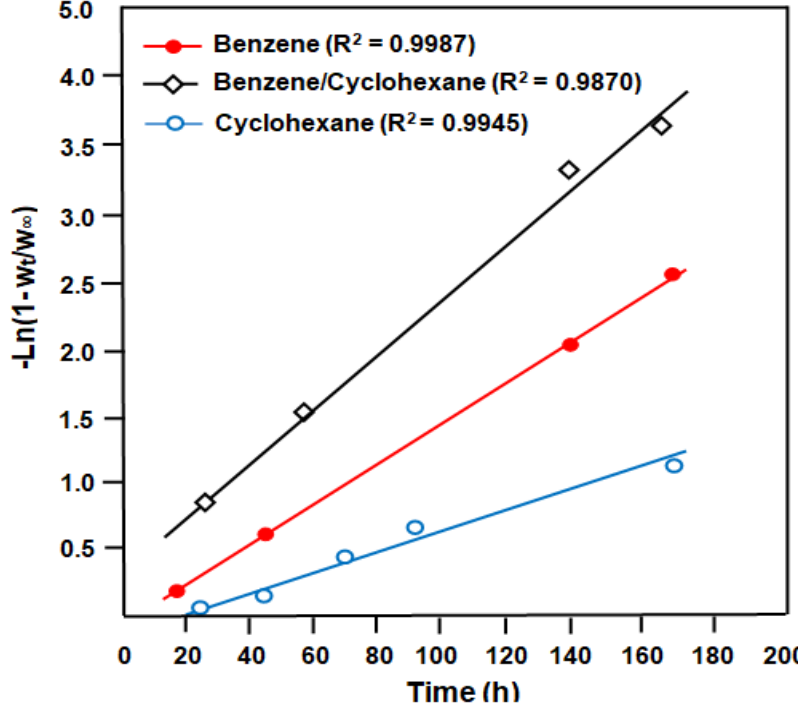
(cid:104) (cid:105) Figure 8. Variation in − Ln 1 − w t of E-VOH / CNT in benzene, cyclohexane, and their mixtures with (cid:4675) of E-VOH/CNT in benzene, cyclohexane, and their mixtures with w t ∞ Figure 8. Variation in −(cid:1838)(cid:1866) (cid:4674)1 − (cid:3050) (cid:3295) (cid:3050) (cid:3295)(cid:3246) equal composition vs. equal composition vs. Ln(t). Table 6. Diffusivity parameters of benzene and cyclohexane in E-VOH membrane measured at 25 °C.